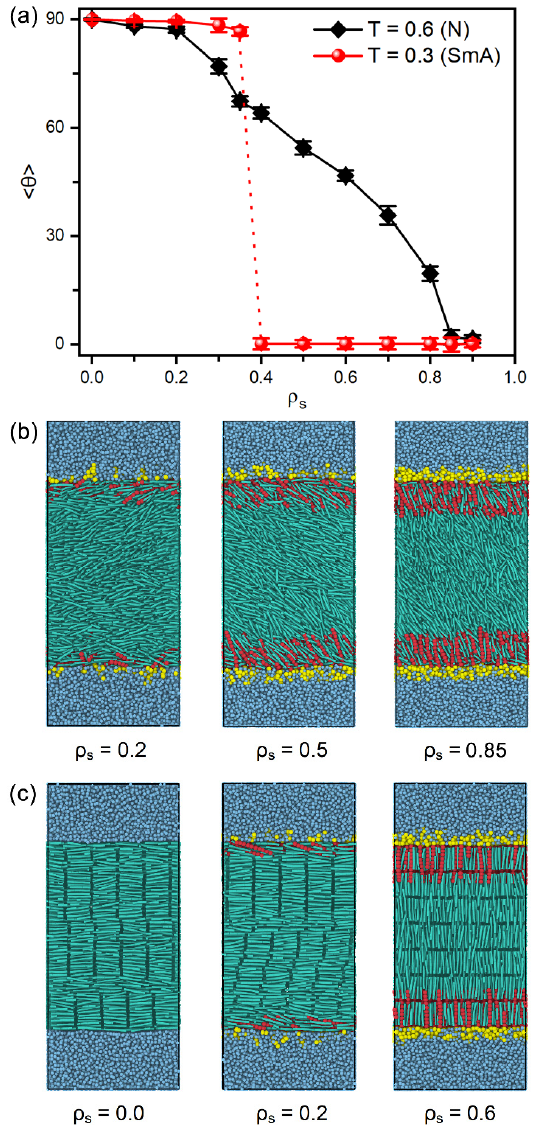
Figure 2. ( a ) Tilt angle of mesogens at the aqueous-LC interface as a function of the surface coverage of amphiphiles and the system temperature, and instantaneous snapshots of the representative anchoring configurations of ( b ) nematic ( T = 0.6, N) and ( c ) smectic ( T = 0.3, SmA)